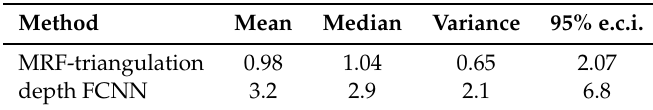
Table 2. Accuracy of localization: distance statistics in meters from reference data collected on site with a GPS